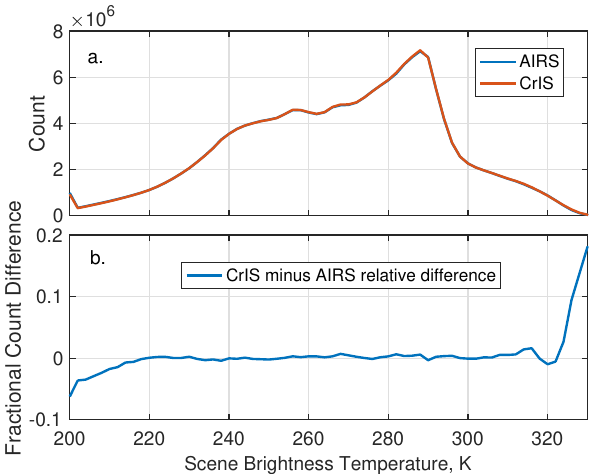
Figure 14. Histogram of CHIRP-AQ and CHIRP-SN observations for the 1% random sampling of the 900.625 cm − 1 channel for calendar year 2016. The AIRS and CrIS results overlay in panel ( a ). In panel ( b ). the fractional count difference, per BT bin, is displayed showing a significantly more hot observations by CrIS compared to AIRS past 320